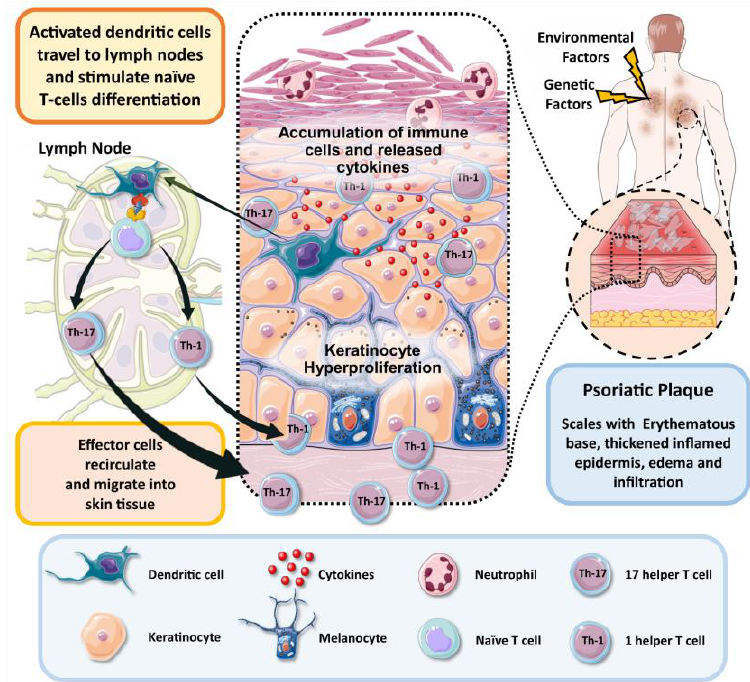
Figure 1. Schematic illustration of pathogenesis of psoriasis.